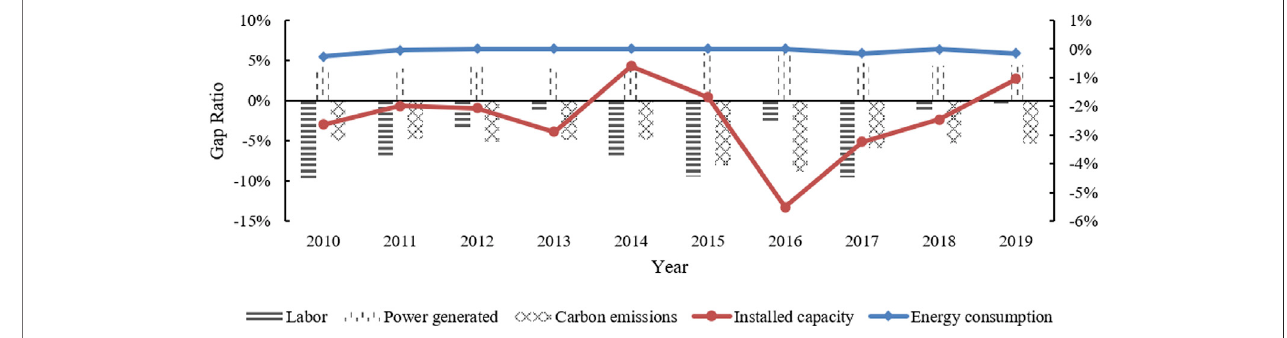
FIGURE 3 | Gap ratio of the inputs/outputs in the power sector during 2010 – 2019.